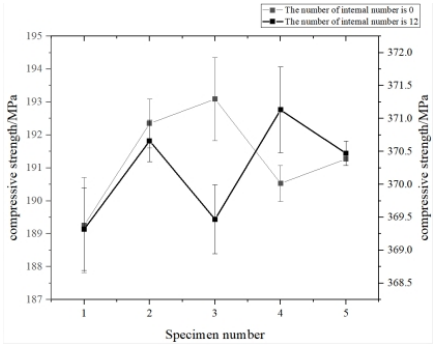
Figure 13. Error bars chart of compression parts error with the number of internal struts 0 and 12, respectively. 3.4.2. Application of the Compound Control Model to Aeronautical Components It is an important optimization goal to reduce the weight of aeronautical components without any compromise for mechanical properties [24]. The composite control of an avi- ation rocker arm processed by traditional casting method is carried out from the design. A casting-shaped aerial rocker arm is designed by compound control method, and the volume of the rocker arm is 47,538 mm 3 , meeting the design requirements of the maximum compressive strength of 375.73. The simplified model was imported into ANSYS for stat- ics analysis. Hole 1 of the rocker arm was subjected to a force of 1800 N in the positive direction of X -axis (Figure 14a), hole 2 was subjected to a force of 2800 N in the negative direction of Y -axis (Figure 14b), hole 3 was a fixed constraint, and the stress cloud diagram of the aerial rocker arm with added loads is shown in Figure 15.